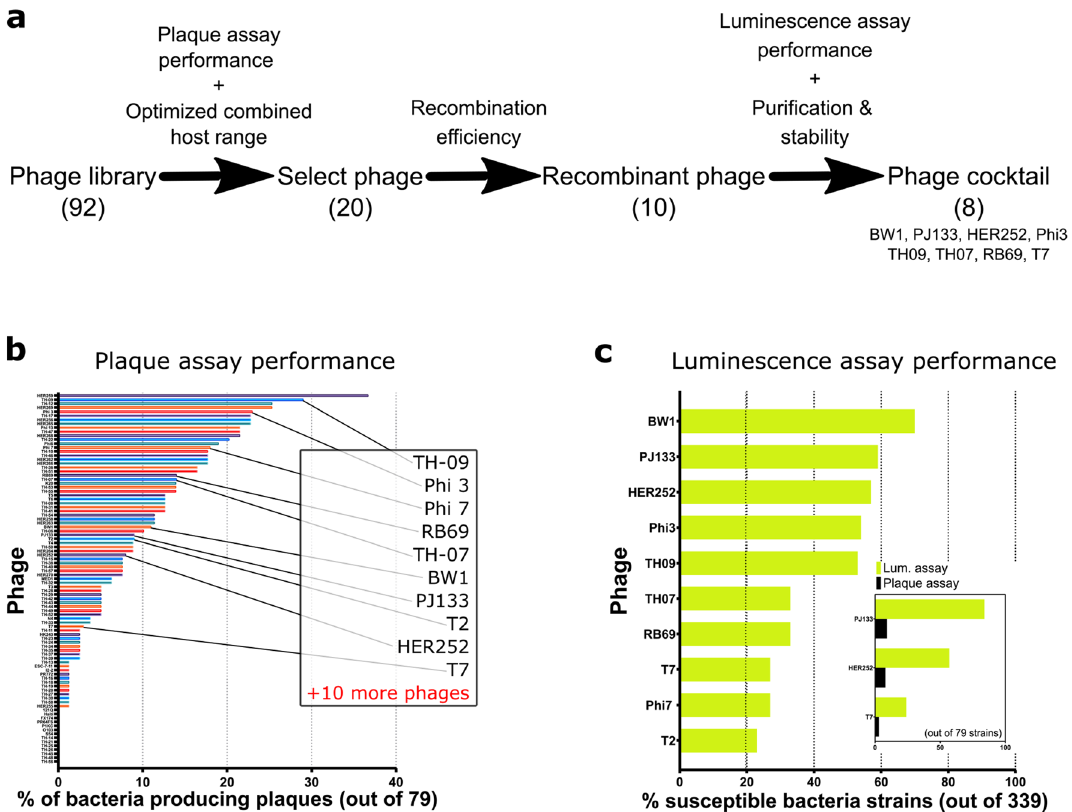
Figure 2. ( a ) Description of the phage selection process: 1. Plaque assay is performed with the entire phage library (92 strains) against a subset of E. coli library (79 strains). Supplemental file 2 contains the detailed plaque plaquing data, 2. Phages are downselected (20 strains) based on the calculated additive host range, 3. Phages are further downselected (10 strains) based on recombination efficiency with NanoLuc reporter, 4. Luminescence assay performance against the entire E. coli library (339 strains), purification success, and general stability to determine the final phage cocktail composition (8 strains). (b) % of bacteria producing plaques upon phage infection. (c) % of E. coli strains susceptible to recombinant phages determined by luminescence assay. Host range is generally broader on the luminescence assay when compared with the plaque assay results on matched strains (inset shows examples; Fig. S2 has the complete list of phages and Supplemental file 2 shows head-to- head comparison on matching